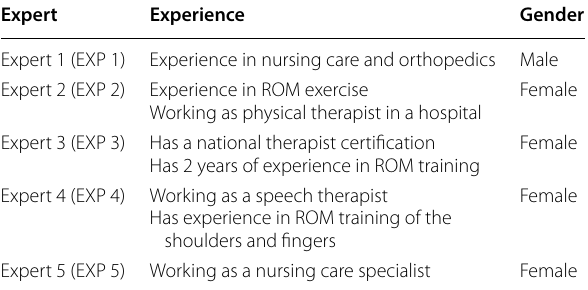
Table 1 A detailed description of the expert experience